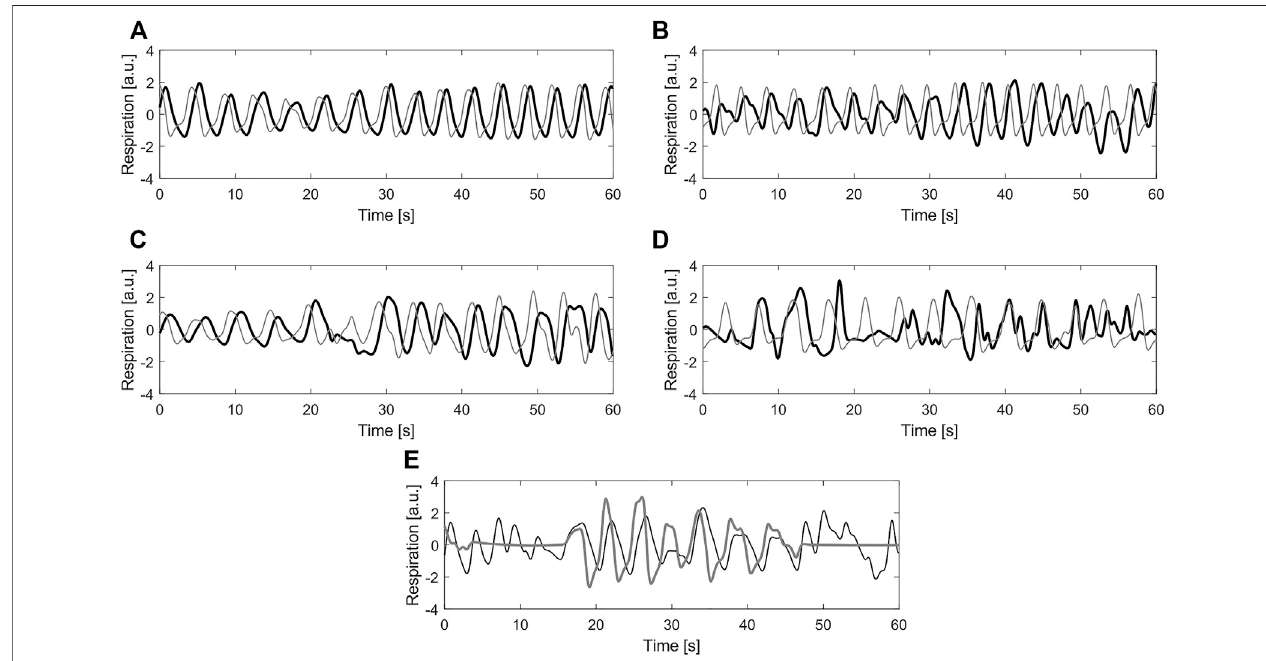
FIGURE 3 | Example of different labels for quality annotation (A) Label 1 — Excellent signal quality (B) Label 2 — Good signal quality (C) Label 3 — Average signal quality (D) Label 4 — Bad signal quality (E) Label 5 — Bad reference quality. In all plots, black line corresponds to the bio-impedance signal and the gray line to the reference signal (a.u.) stands for arbitrary